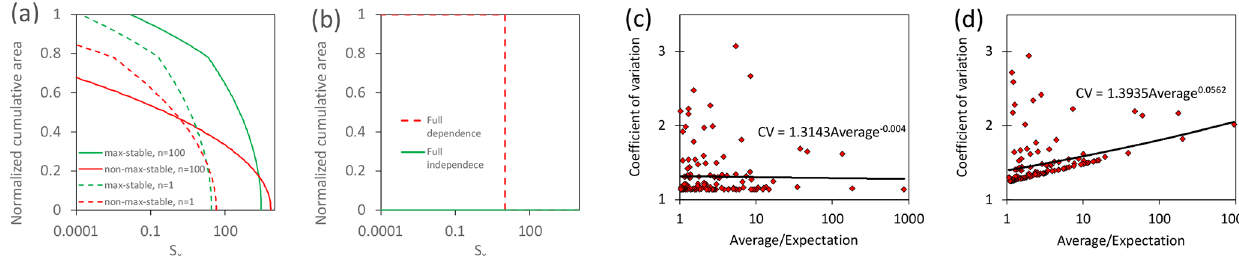
Figure 3. The area function and corresponding characteristics: (a) area function of the biggest event of Fig. 1, (b) area functions for the limit cases (examples), and (c) relation of CV to average for the max-stable case of Fig. 1b and (d) for the non-max-stable case of Fig. 1d (for events with average > 1, the distance between the support points is 0.1 for the computation of the average in the region [ − 4,